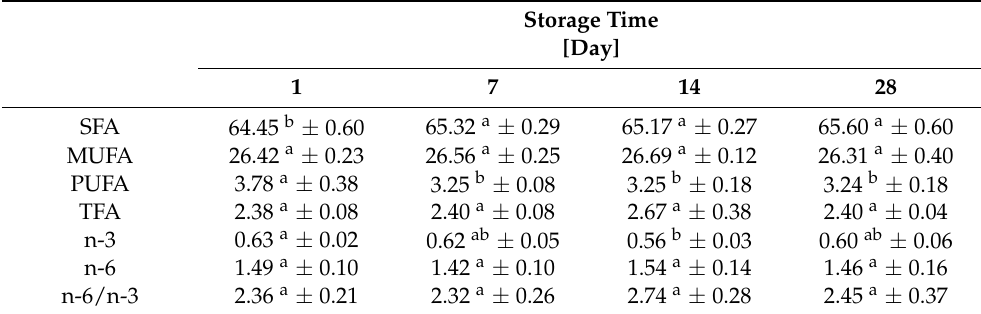
Table 3. Fatty acid composition in fat extracted from the milk fat–inulin spread stored at 5 ◦ C for four